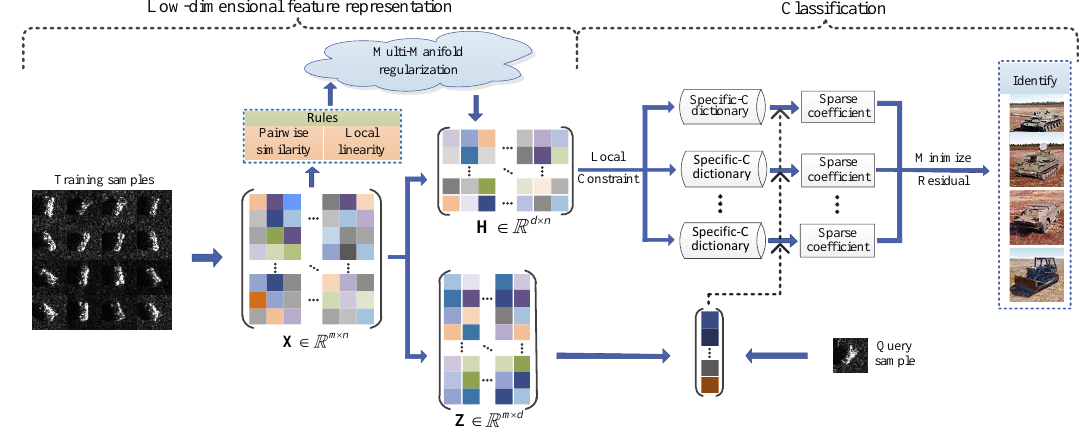
Figure 1. Overview of the target recognition procedure based on the proposed strategy. The proposed strategy consists of two phases: low-dimensional feature representation and classification. The first phase uses a multi-manifold regularized low-rank approximation to obtain the low-dimensional feature representation of training samples H and mapping matrix Z . The feature of the query sample can be obtained by Z . The second phase uses the local sparse representation for classification. The query sample is represented as a linear combination of class-specific dictionaries. According to the representation coefficients, the identify of the query sample is reached by evaluating the class of samples, which could result in the minimal reconstruction